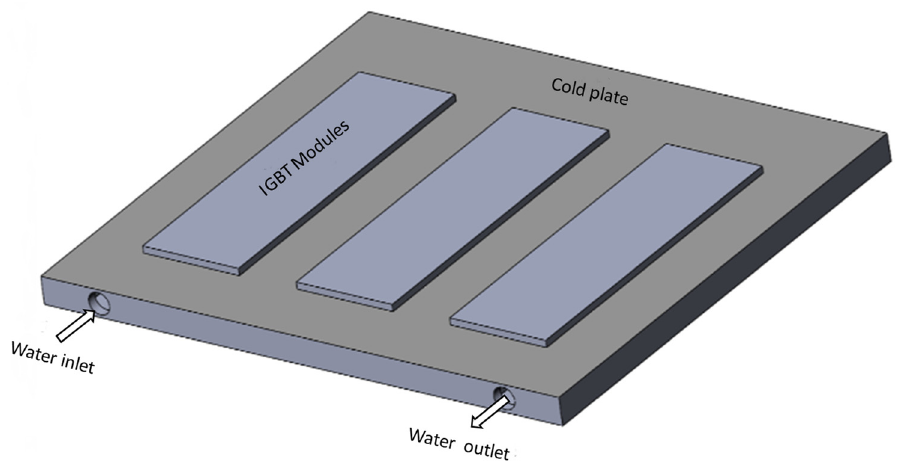
Figure 1. External structure of water-cooled plate.